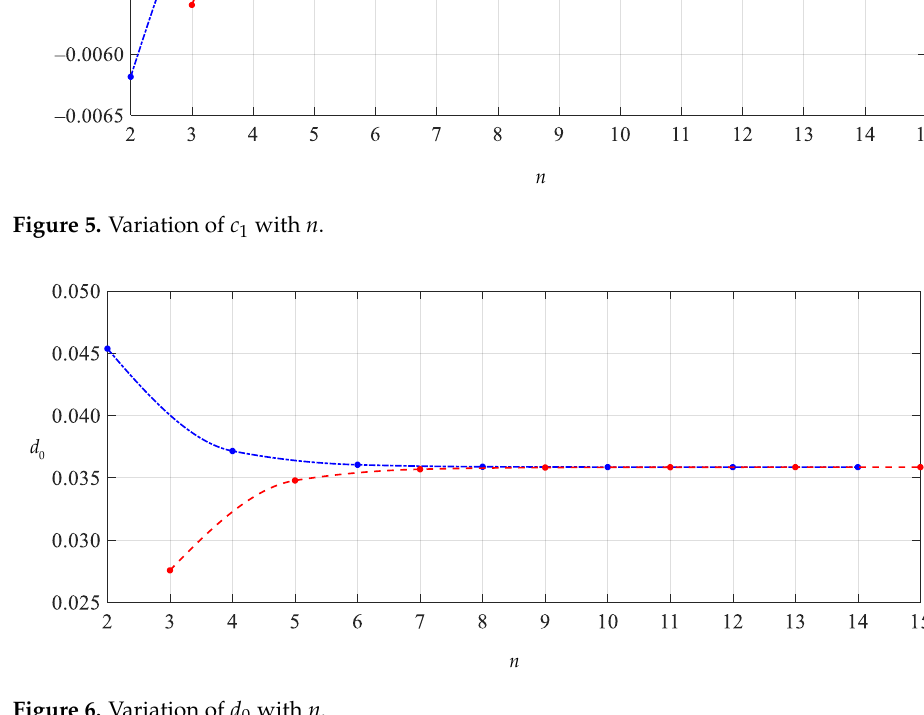
Figure 6. Variation of d 0 with n .